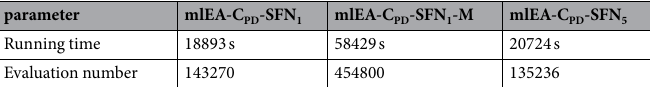
Table 1. The evaluation number and running time of these three